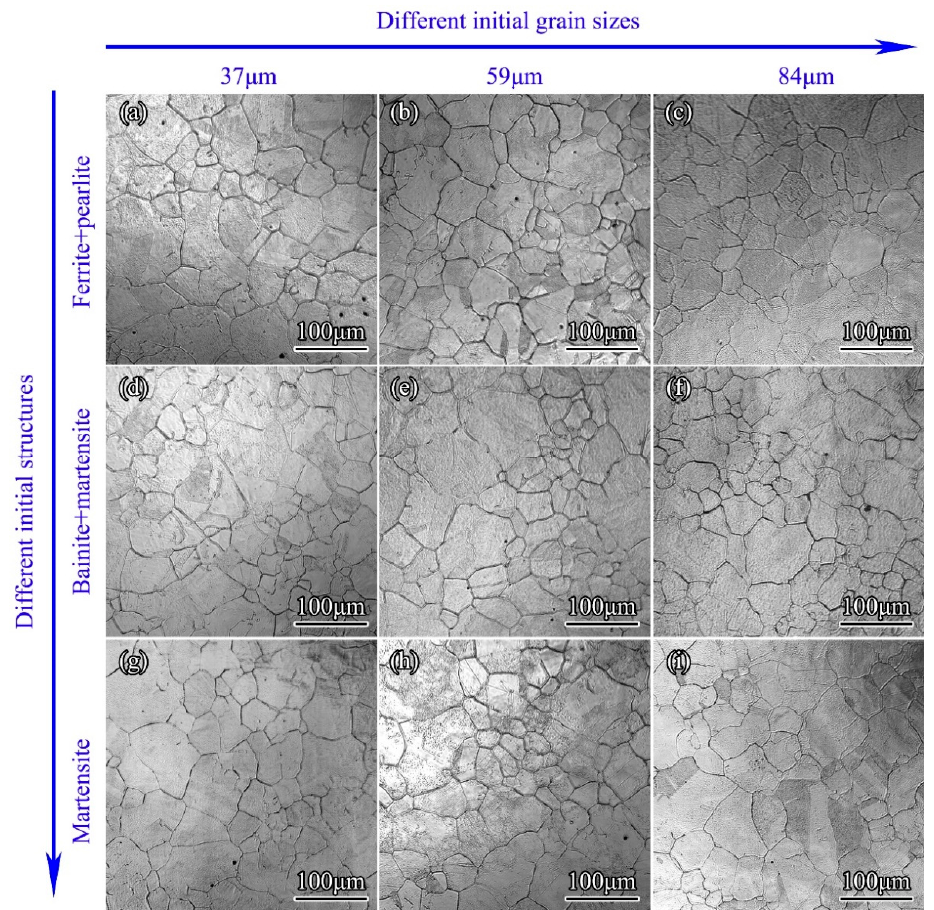
Figure 7. In situ observation results of 300M steel with different initial microstructures after holding at 1050 °C for 1200 s. The initial grain sizes and initial structures for each experiment were marked on the edge. The average grain sizes were 58, 55, 54, 56, 63, 55, 53, 58 and 65 μ m, respectively.